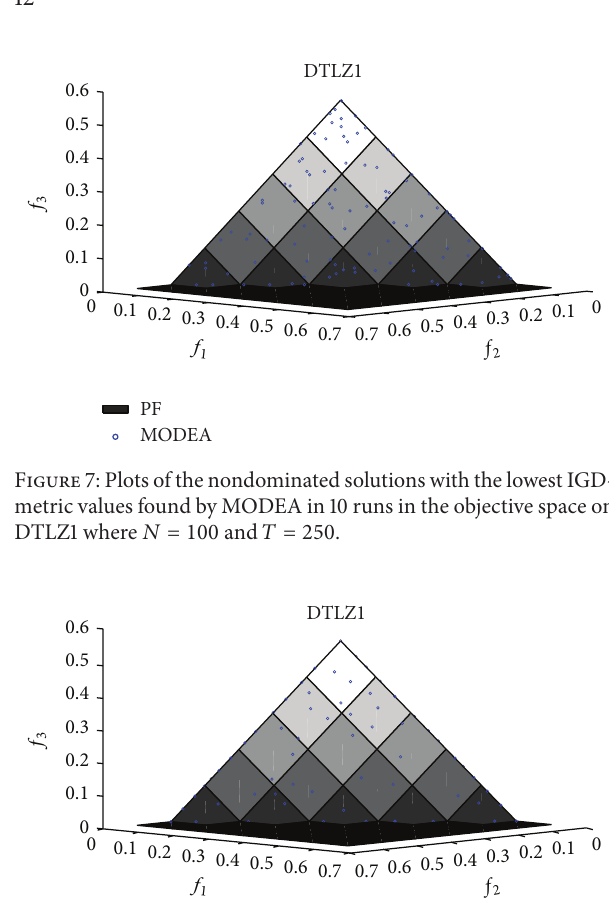
Figure 10: Plots of the nondominated solutions with the lowest IGD-metric values found by MODESA in 10 runs in the objective space on DTLZ2 where 𝑁 = 100 and 𝑇 = 250